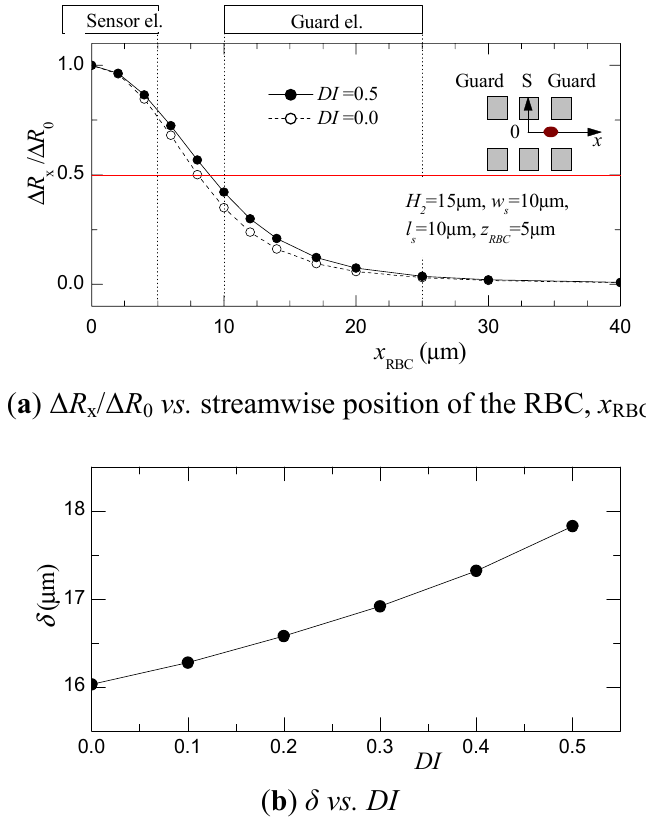
Figure 5. ( a ) Resistance distribution Δ R ( b ) the relationship between the half-bandwidth of Δ R DI